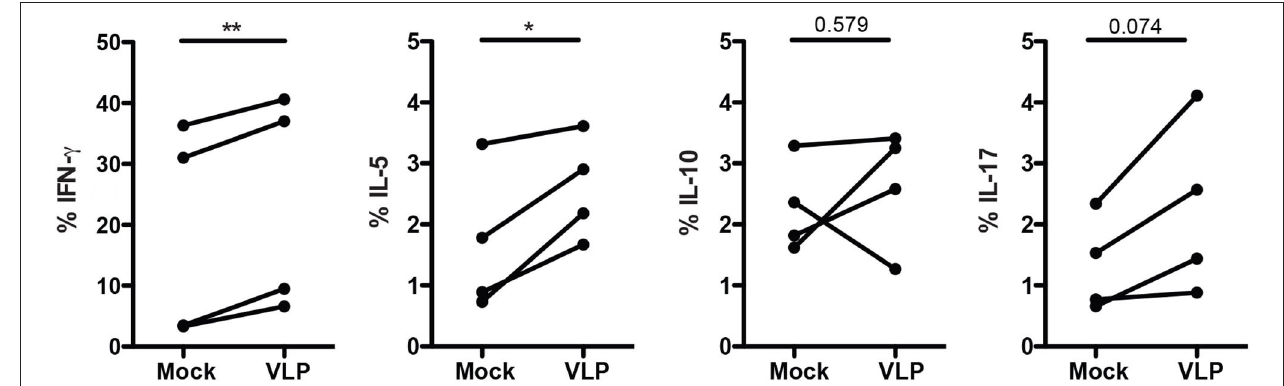
FIGURE 4 | ANDV-GP induces Th1/Th2 cytokine expression on memory CD4 + T cells. Frequency of memory CD4 + T cells expressing the following cytokines (IFN γ , IL-5, IL-10, and IL-17) in HD stimulated with VLP in presence of anti-CD3/CD28 beads or mock as control after 3 days in cell culture ( n = 4). Each line represents a